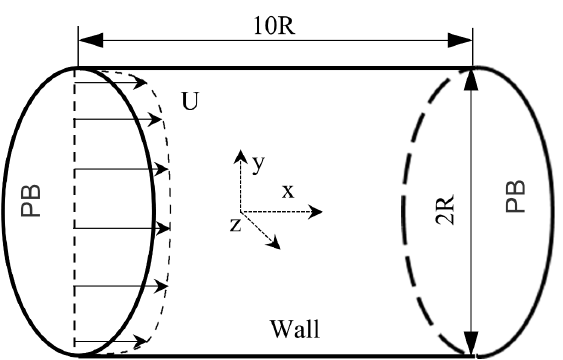
Figure 6. Computational domain for the pipe flow. The left and right sides are the periodic bound ‐ ary conditions.